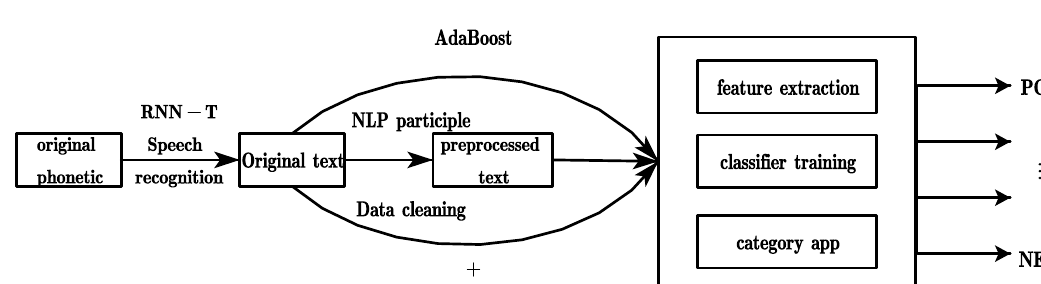
Figure 5. Schematic diagram of SSE workflow.